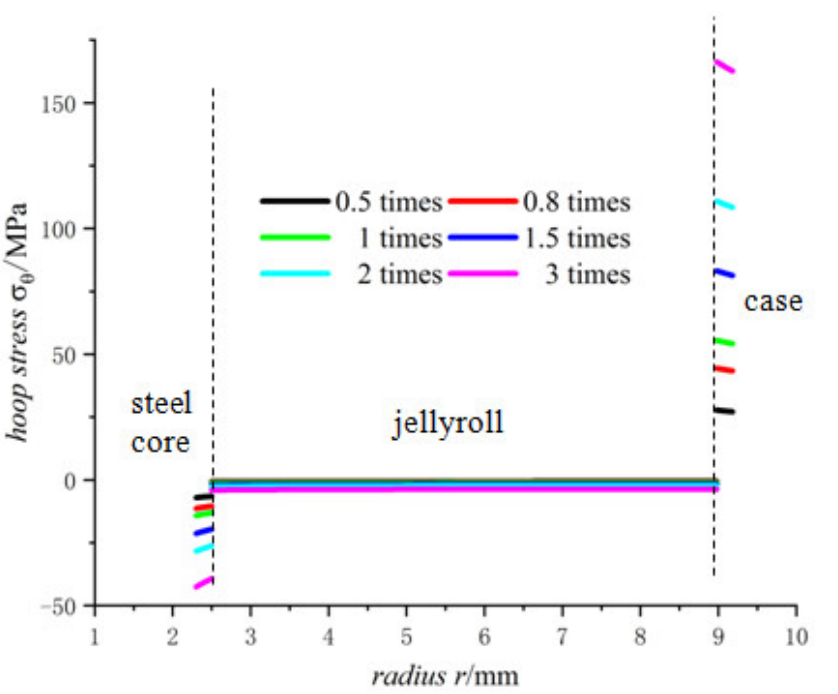
Figure 12. Hoop stresses of 18650 battery at different lithium-ion concentrations.